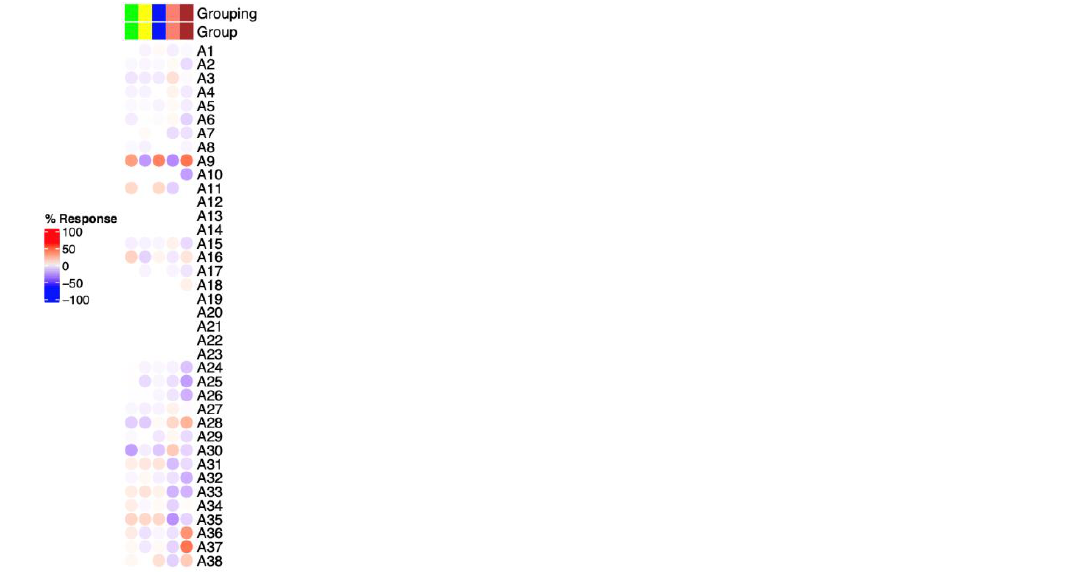
Figure 3. Mapping of the blood transcriptome signature of LRBA-deficient diabetic patient at the module aggregate level. The columns on this heatmap represent proband, healthy sibling and three healthy controls (from right to left). Module aggregates (A1 to A38) are arranged as rows.